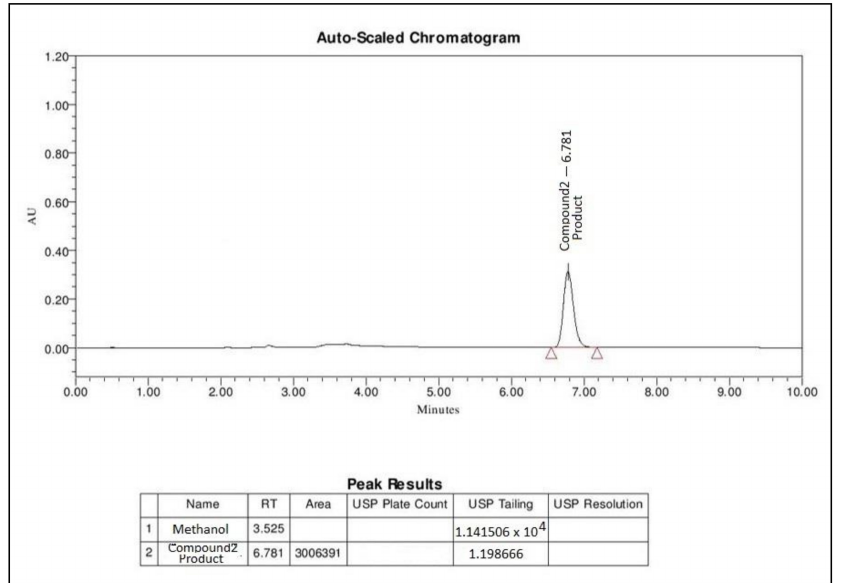
Figure 7. Determination of “3-(Naphthalen-1-ylimino)indolin-2-one” in a lipid-based self- nanoemulsifying formulation (SNEDDS) prepared in-house. The data represented a concentration of compound ( 2 ), from a SNEDDS formulation. The SNEDDS formulation consisted of a mixture of long chain triglycerides (black seed oil), medium chain mono- and di-glycerides (Imwitor 988), and a water-soluble non-ionic surfactant (Kolliphor EL) with 5 mg of compound ( 2 ) as solubilized form. From the results, it can be stated that the current method quantified compound ( 2 ) precisely (98.2%), which was present in a single unit dosage form (Table 3). Table 3. Determination and % recovery of “3-(Naphthalen-1-ylimino)indolin-2-one” (compound ( 2 )) in in-house